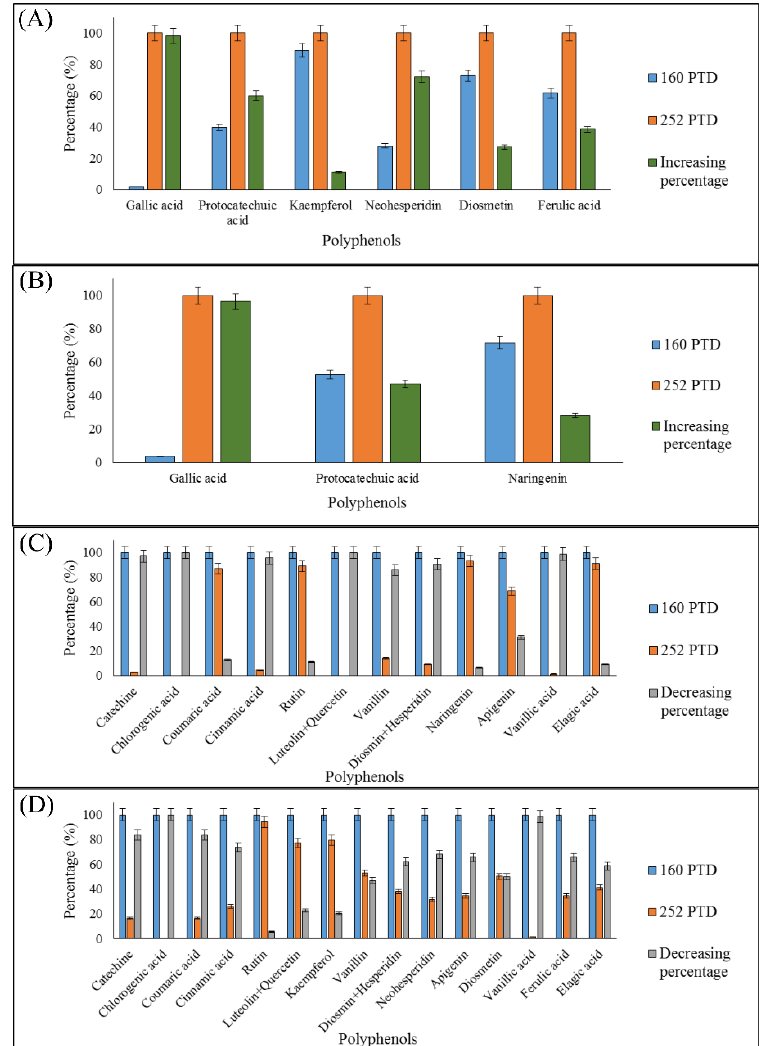
Figure 2. Change in the percentage of polyphenols between the first (160 PTD) and the last harvest (252 PTD). ( A ) Polyphenols from immature peppers that increased during harvests. ( B ) Polyphenols from mature peppers that increased during harvests. ( C ) Polyphenols from immature peppers that decreased during harvests. ( D ) Polyphenols from mature peppers that decreased during harvests.